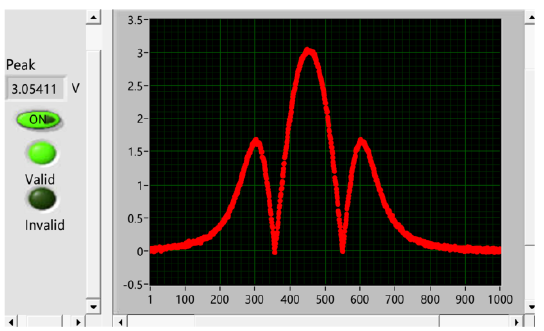
Figure 14. Waveform of second harmonic for 0.2% CH 4 buffered by N 2 . To visualize the variation of detection results with sample concentrations, we present the peaks of harmonic signals obtained by measuring all samples with their concentrations ranging from 400 ppm to 1%. According to the fitting, the peak of harmonic has a highly linear dependence on the sample concentration, as predicted in Section 3.2. In Figure 15, a regression coefficient of R = 0.9976 was derived from the linear fitting described by with y being the peak value of detector signal and x being the methane